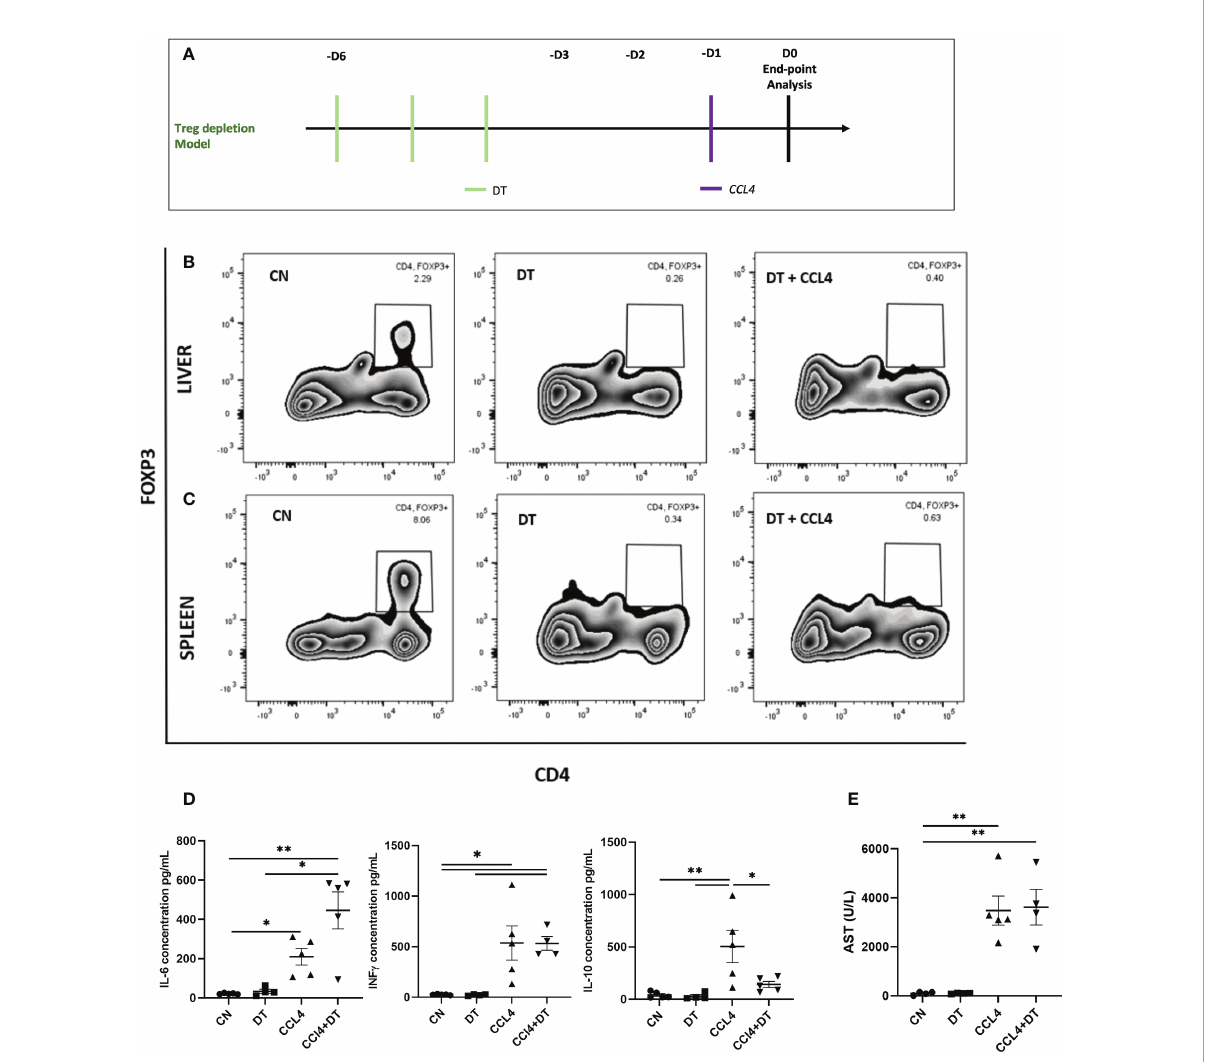
FIGURE 2 Hepatocyte necrosis is unaltered by Treg depletion. (A) Schematic representation of the experimental design for DT induced Treg depletion, 1ug diphtheria toxin (DT) was injected in Foxp3-DTR mice, 3 days prior to CCL ₄ administration. Depletion of Foxp3+ cells was analysed by fl ow cytometry in (B) liver and (C) spleen and the results are shown as percentages from fi xable live/dead stained viable CD4+ cells and representative of 3 individual experiments. (D) Serum concentration of IL-6, IFNg and IL-10 cytokines (pg/ml) were measured at 24h in the serum obtained by cardiac puncture following DT and CCL ₄ treatment, determined by ELISA (n=5) along with (E) AST levels (n=4). The values are shown as the mean ± SEM and one-way ANOVA with Tukey ’ s multiple comparison test has been performed to show statistical signi fi cance, *P < 0.05, **P <